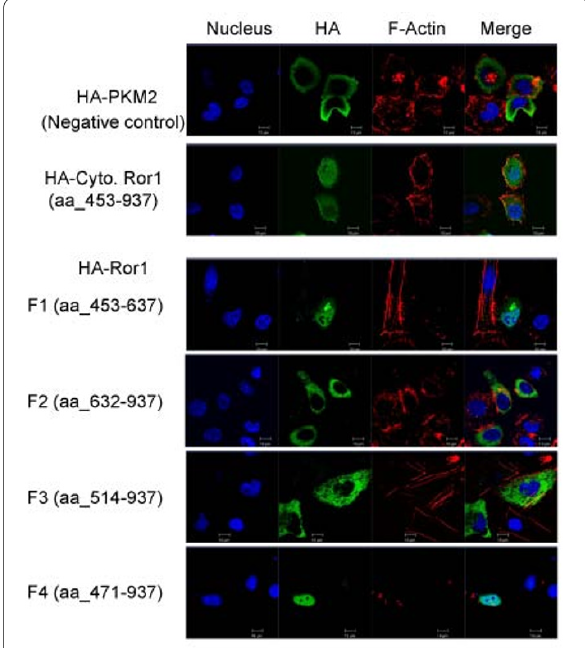
Figure 2 Identification of the minimal Ror1 domain that plays a critical role in nuclear accumulation . Confocal microscopic analysis was used to detect subcellular localization of Ror1 fragments. HR cells were transfected for 24 hours with indicated Ror1 fragments and stained with anti-HA monoclonal antibody (green) followed by a fluo- rescent (FITC) secondary antibody and with phalloidin rhodamine (red). DAPI staining shows the nucleus. PKM2, a known cytoplasmic protein, served as a negative control.